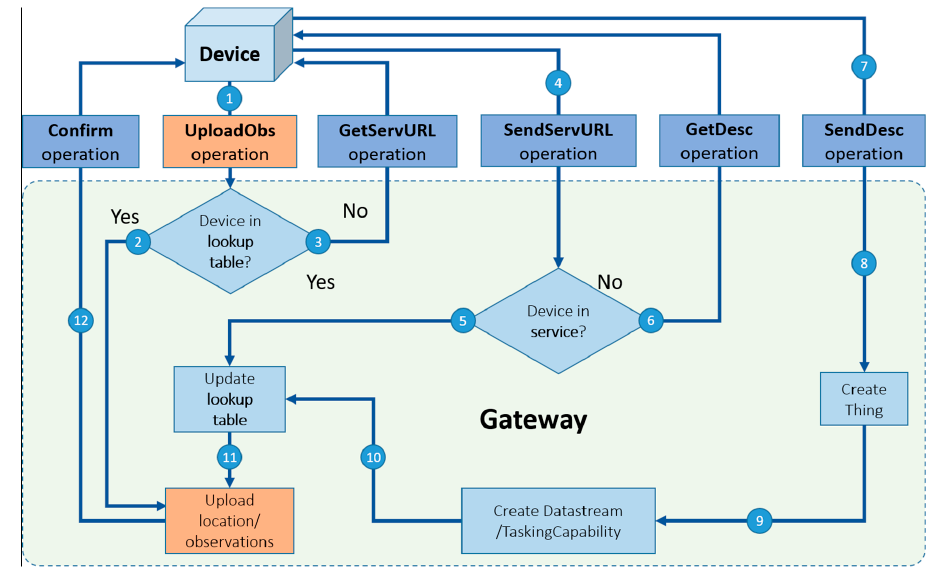
Figure 7. The workflow of the sensing capability registration procedure.